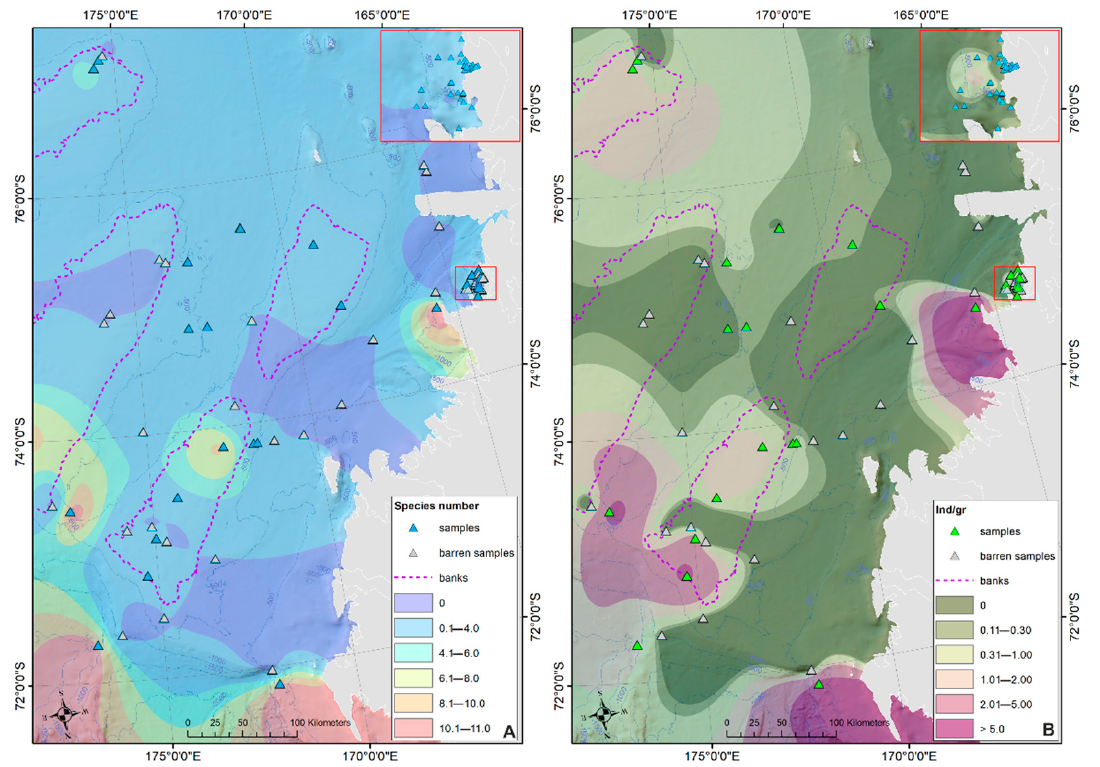
Figure 8. GIS Predictive ostracod species richness ( A ) and total abundance (i.e., n° specimens/g) ( B ) distribution maps interpolated in GIS applying the spline method using barriers.